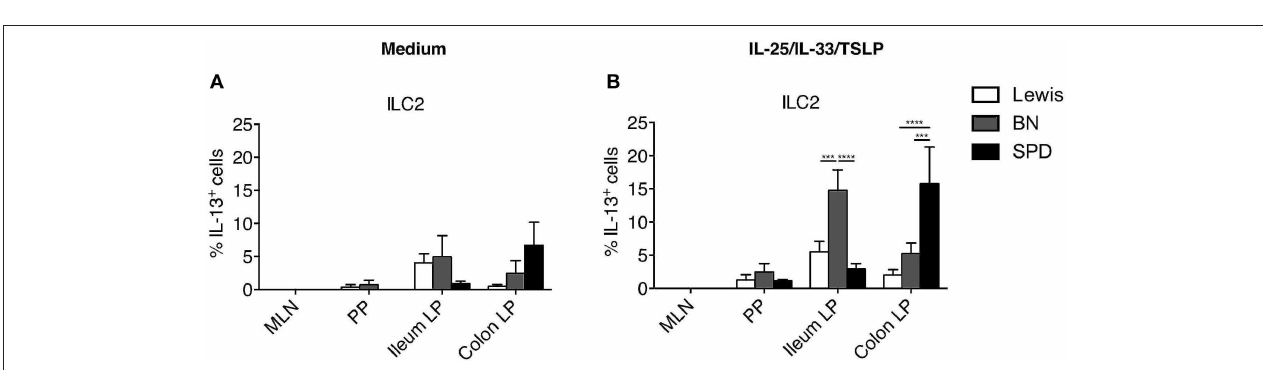
FIGURE 6 | Comparison of ILC2-derived IL-13 production between rat strains. (A) The percentage of constitutive ILC2-derived IL-13 production in the indicated tissues of LEW (white bars), BN (gray bars) and SPD (black bars) rats and (B) after 4h of stimulation with ILC2 specific cocktail. ( n = 6) per each tissue and rat strain. Numeric data represents means ± SEM, significance was determined at P < 0.05. *** p < 0.001, **** p < 0.0001.